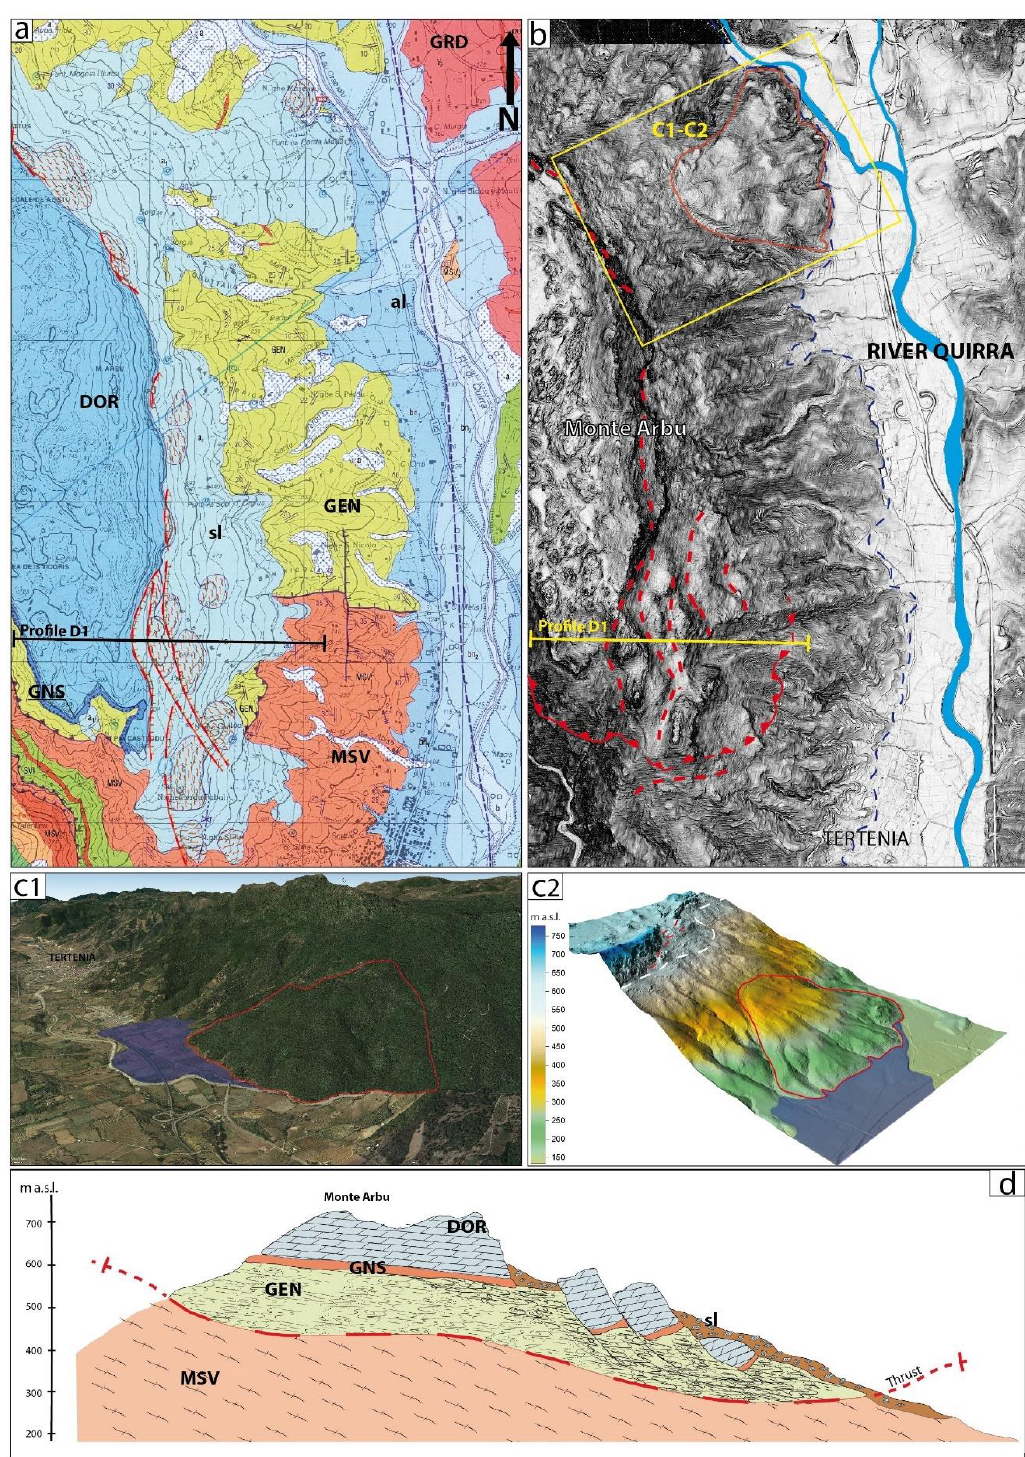
Figure 9. ( a ) Geological map of the eastern slope of Monte Arbu (Tertenia). Geolithological legend: MSV — Monte Santa Vittoria Formation; GEN — Filladi Del Gennargentu Formation; GNS — Genna Selole Formation; DOR — Dorgali Formation; al — terraced and current alluvial deposits; sl — slope deposits. [57]. ( b ) LiDAR hillshade with the main geomorphological feature of the DGSD. ( c1 ) Photographic 3D view with the DGSD border marked in red and the terraced alluvial deposit in blue. ( c2 ) Three-dimensional LiDAR of the Tertenia paleo-DGSD with the border marked in red and the terraced alluvial deposit in blue. ( d ) Interpretative geological cross-section of the DGSD showing it sliding on highly fractured rock due the underlying Paleozoic